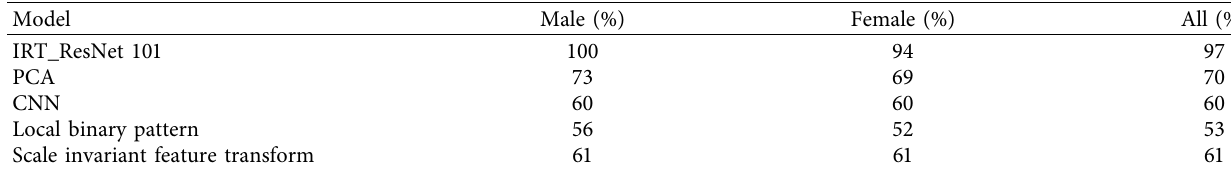
Table 4: Comparisons of different